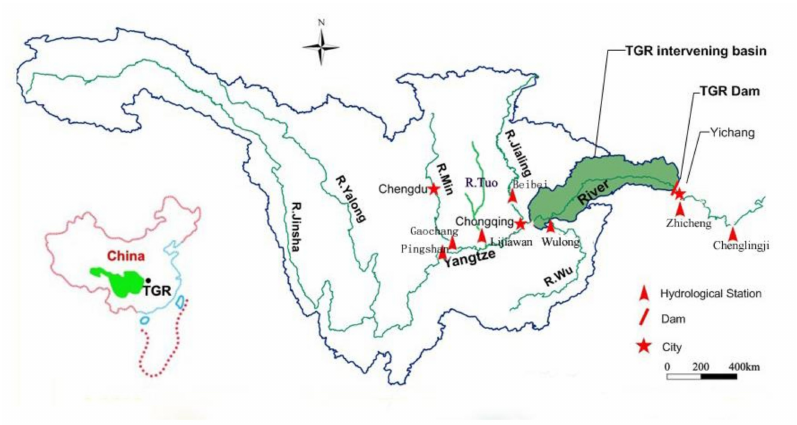
Figure 2. Schematic of the Three Gorges Reservoir (TGR) in China.